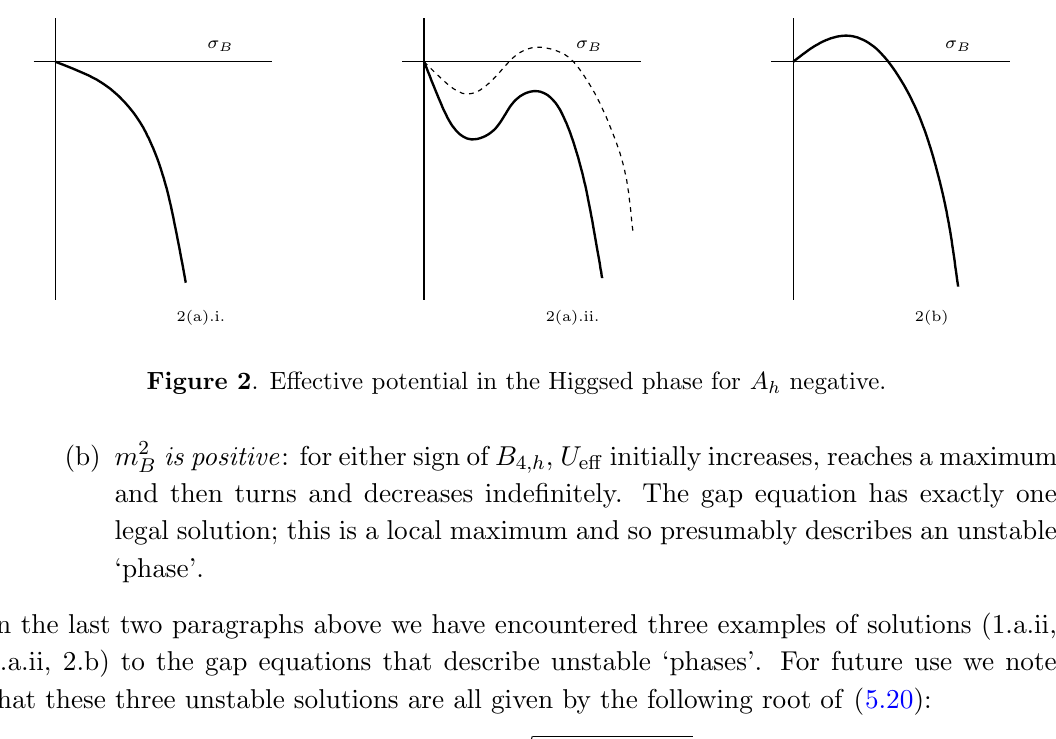
, U initially increases, reaches a 4 ;h e(cid:11)